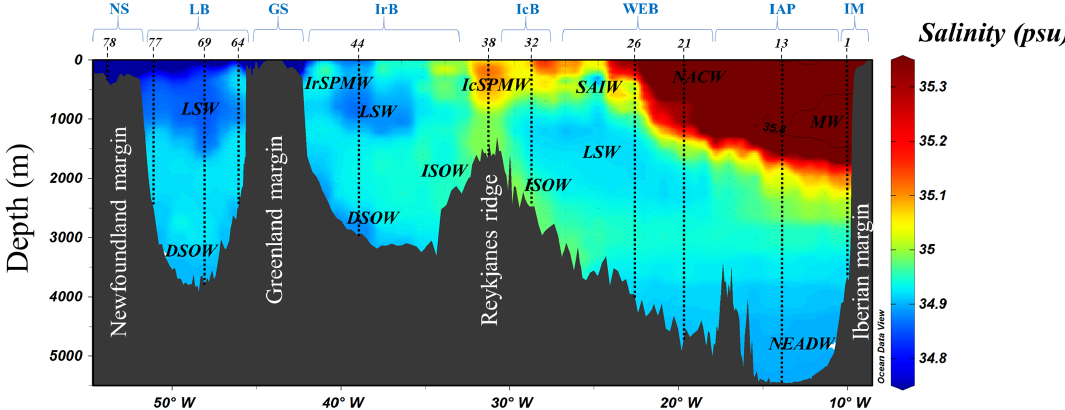
Figure 2. Salinity section during the GEOVIDE cruise with water masses indicated in black italic font. A salinity contour of 35.8psu has been applied to identify the Mediterranean Water (MW) to the east. From right to left: North East Atlantic Deep Water (NEADW); North Atlantic Central Water (NACW); Labrador Sea Water (LSW); Sub-Arctic Intermediate Water (SAIW); Iceland–Scotland Overflow Water (ISOW); Iceland Sub-Polar Mode Water (IcSPMW); Denmark Strait Overflow Water (DSOW); Irminger Sub-Polar Mode Water (IrSPMW). Station locations are indicated by the numbers above the section and biogeochemical provinces are indicated in blue font above station numbers. This figure was generated using Ocean Data View (Schlitzer, R., Ocean Data View, http://odv.awi.de/, 2017). Table 2. Concentration (in nmolL − 1 ) of particulate trace elements (PFe, Pal, PMn, and PP) in suspended particles collected in diverse regions of the world’s